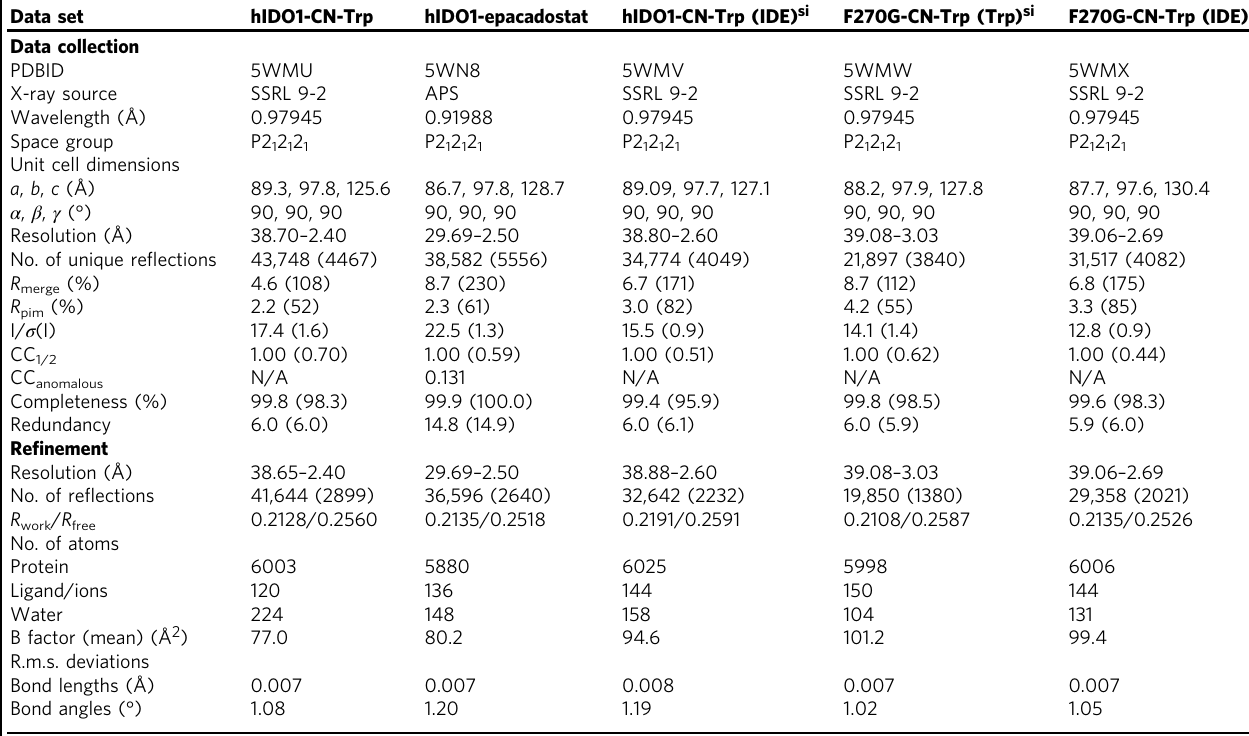
Table 1 Crystallographic data collection and re fi nement statistics Data set